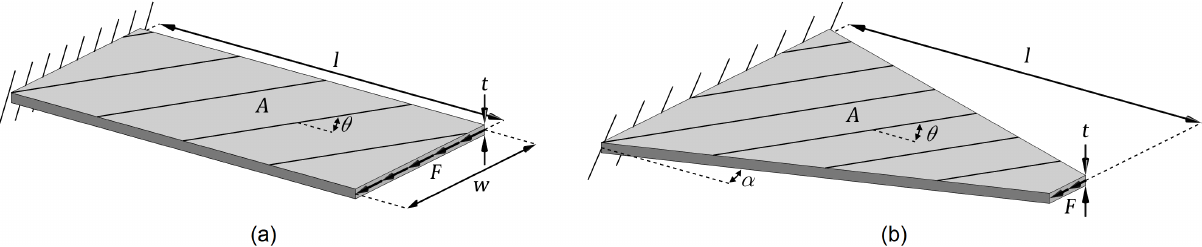
Figure 1. Schematic diagrams of ( a ) non-tapered and ( b ) width-tapered cantilever laminated composite plates with identical thickness, length, and surface areas.